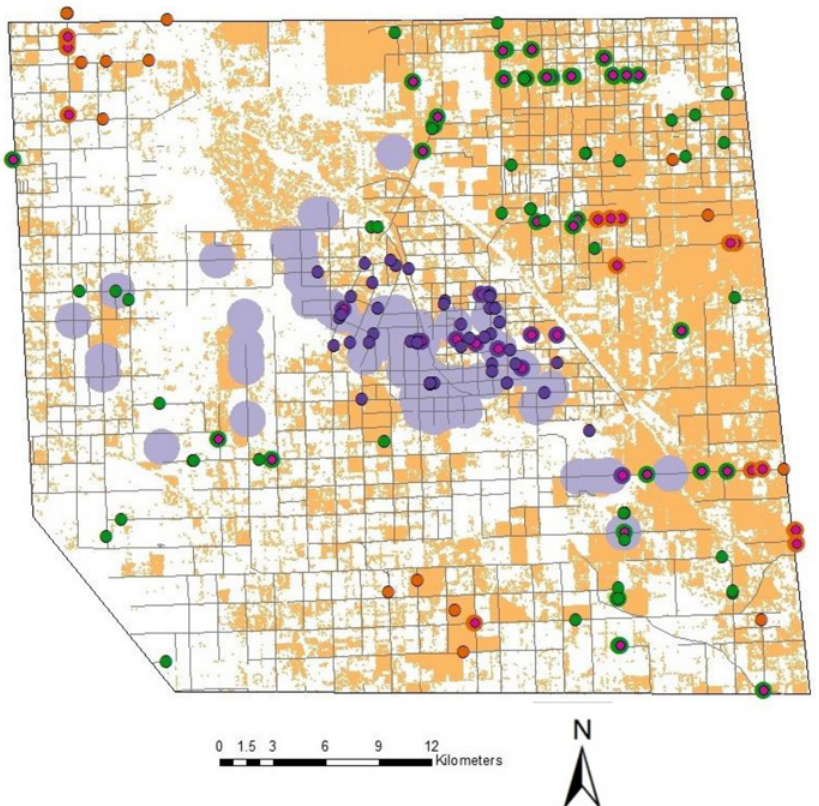
and hay-production (orange) areas. Non-clustering populations are also evident (green). Transgenic feral populations (pink) occur in seed- and hay-production areas, as well as along major roads used to transport